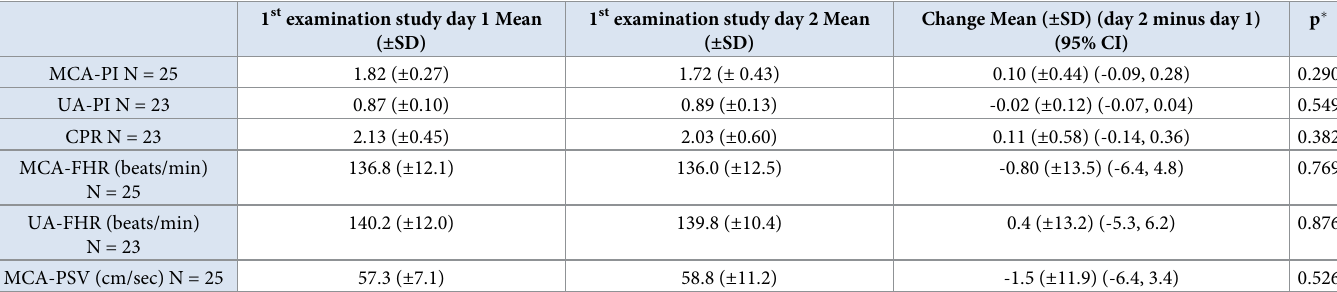
Table 4. MCA-PI, UA-PI, FHR, CPR, and MCA-PSV values in the first examination study day 1 and study day 2 (baseline